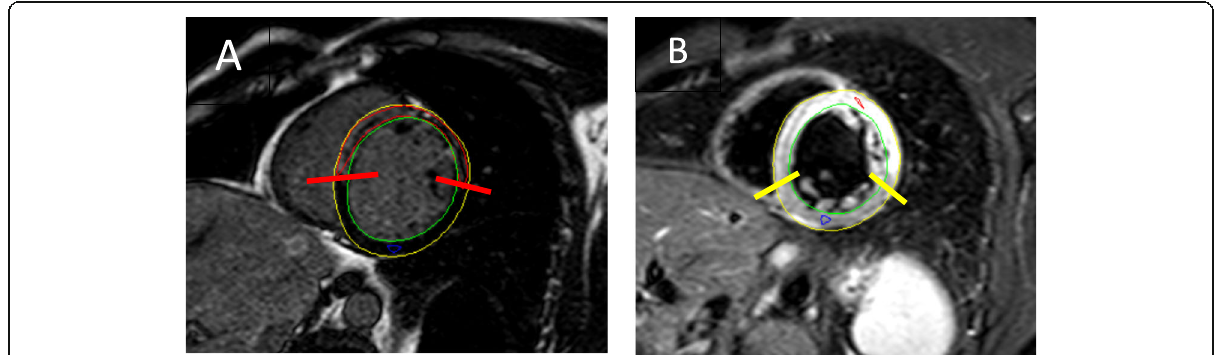
Fig. 1 Cardiac MRI at 1 week in a patient with a large anterior myocardial infarction. a Late enhancement imaging allowed for the definition of infarct size (hyper-enhanced myocardium, between red arrows). B T2-weighted sequence demonstrated a large area at risk (with edema, between yellow